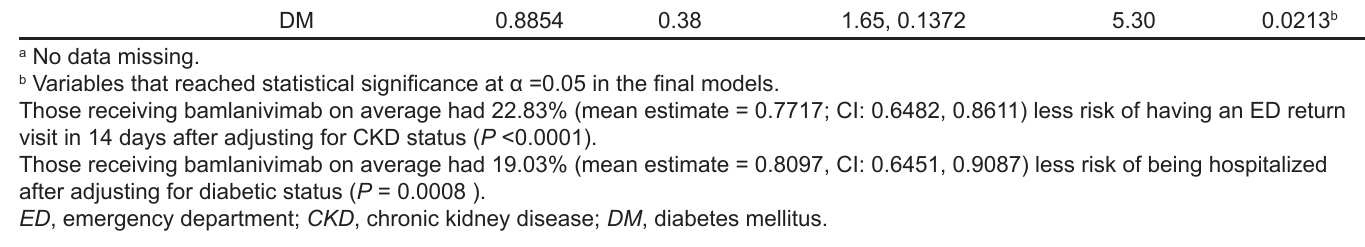
a No data missing. b Variables that reached statistical significance at α =0.05 in the final models. Those receiving bamlanivimab on average had 22.83% (mean estimate = 0.7717; CI: 0.6482, 0.8611) less risk of having an ED return visit in 14 days after adjusting for CKD status ( P <0.0001). Those receiving bamlanivimab on average had 19.03% (mean estimate = 0.8097, CI: 0.6451, 0.9087) less risk of being hospitalized after adjusting for diabetic status ( P = 0.0008